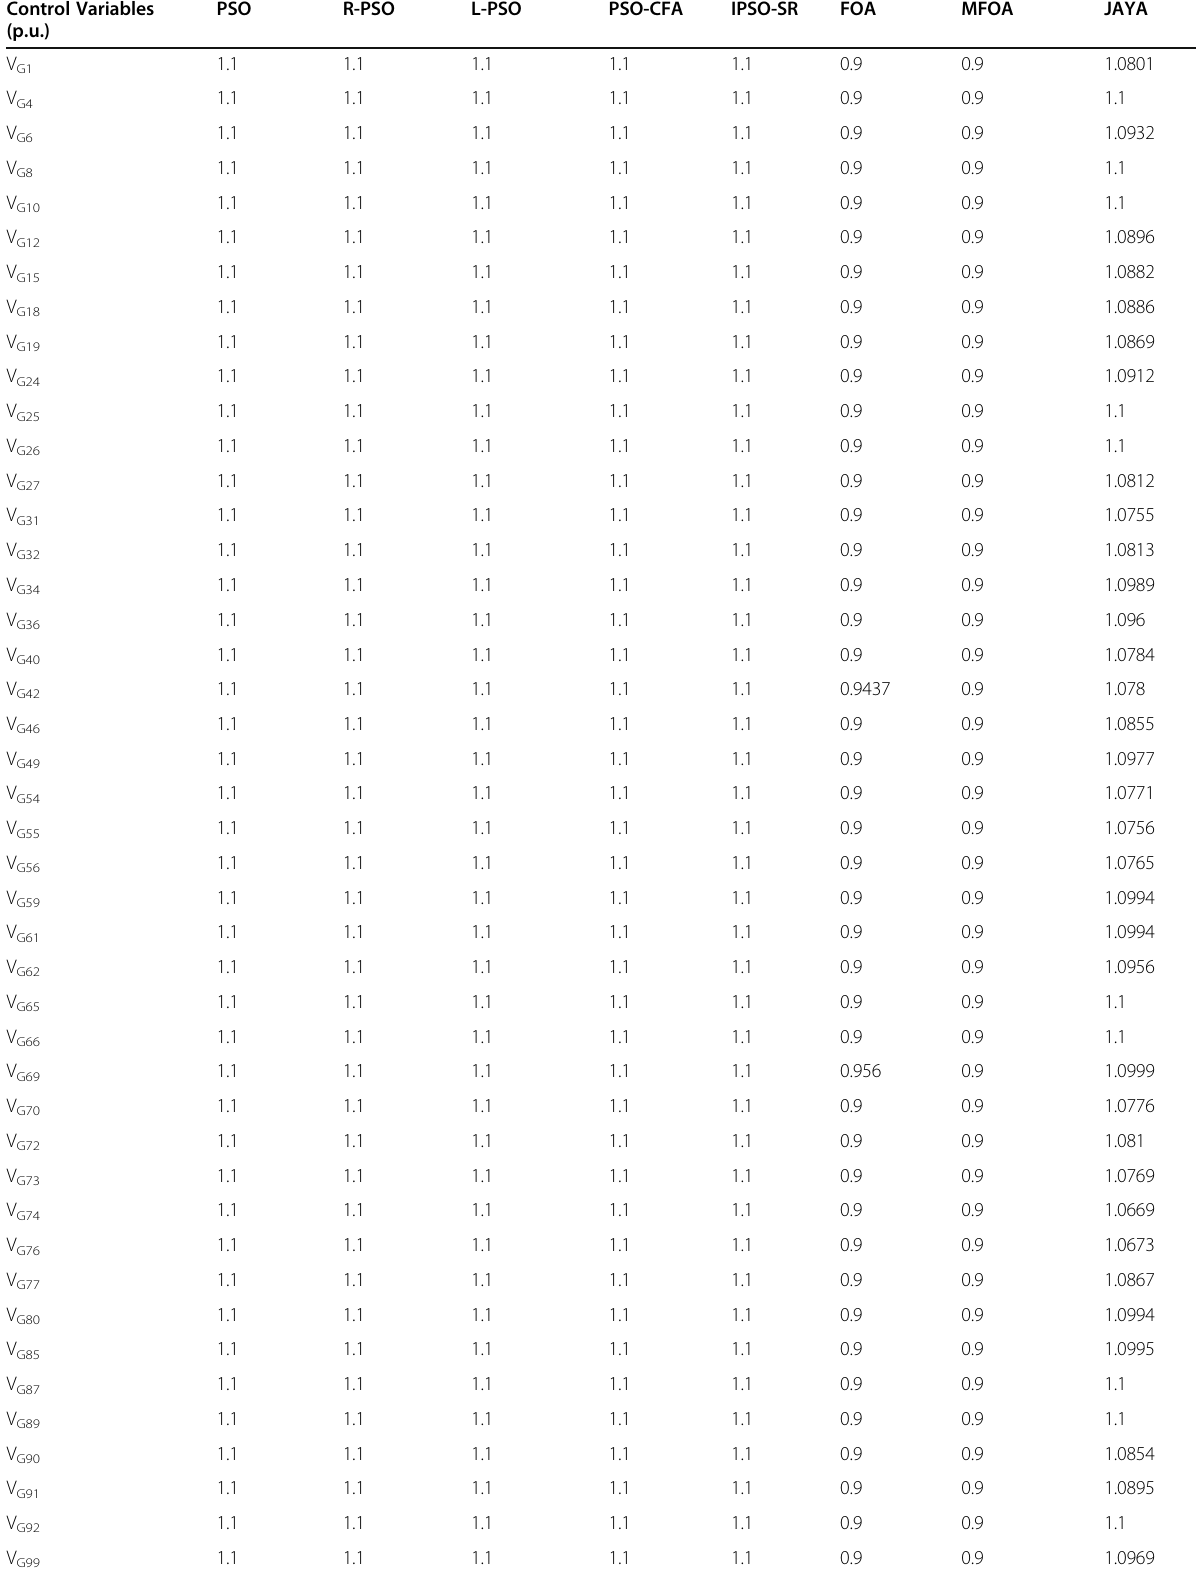
Table 10 Simulation results on the IEEE 118 bus system using different algorithms without DG injection Control Variables